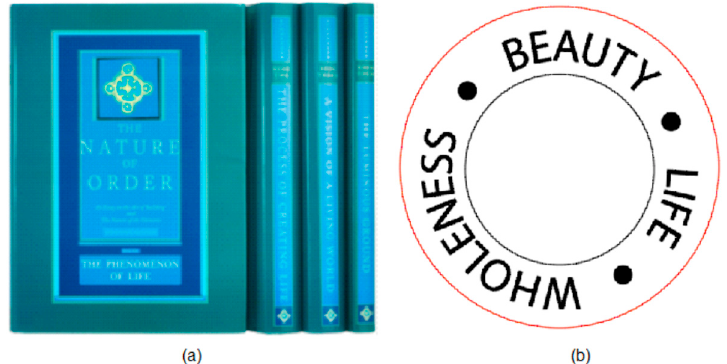
Figure 1. (Color online): The Nature of Order and its major theme. (Note: ( a ) the four volumes of the book, and ( b ) Maggie’s circle on life, beauty, and wholeness, with the first two out of the underlying structure of wholeness.)